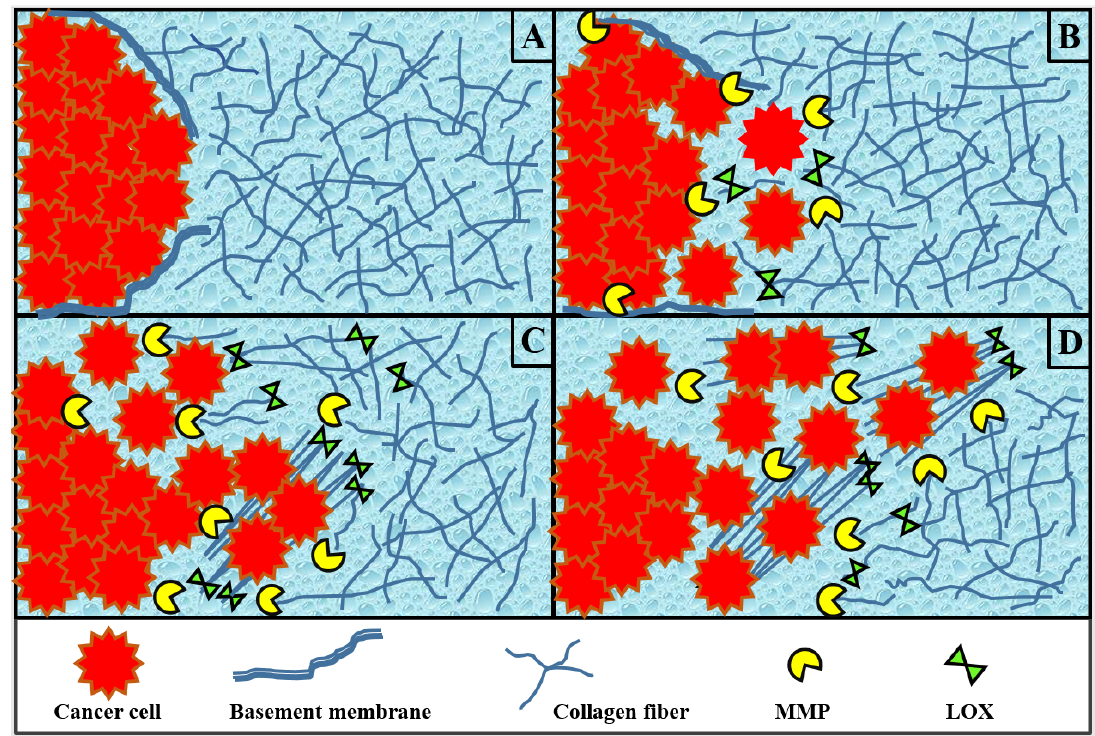
Figure 1. Dynamics in a metastatic tumor microenvironment: ( A ) The basement membrane around the edge of the primary tumor (cluster of cancer cells in red) has already been perforated by cancer cells. The surrounding collagen fibers are randomly oriented in the extracellular matrix (ECM). ( B ) Enzymes metalloproteinase (MMP) and lysyl oxidase (LOX) are secreted by cancer cells to degrade and cross-link collagen fibers. MMP generates spaces for cancer cells to begin detaching away from the primary tumor mass to invade the ECM. ( C ) Meanwhile, aligned and cross-linked collagen fibers form a fibrous pathway along which cancer cells prefer to travel. ( D ) Collagen fibers continue to be cross-linked, aiding the maneuvers of cancer cells further through the